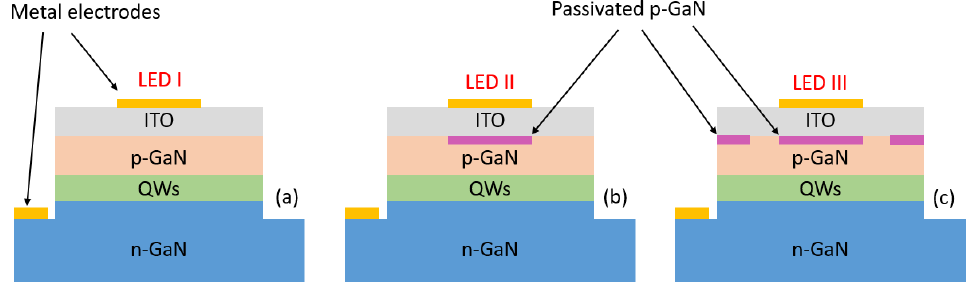
Figure 1. Experimental LEDs cross-section schematics in case of ( a ) LED I — reference LED; ( b ) LED II — LED with the hydrogen passivation applied under the electrode; ( c ) LED III — LED with the hy- II—LED with the hydrogen passivation applied under the electrode; ( c ) LED III—LED with the drogen passivation applied under the electrode and along the mesa perimeter. hydrogen passivation applied under the electrode and along the mesa